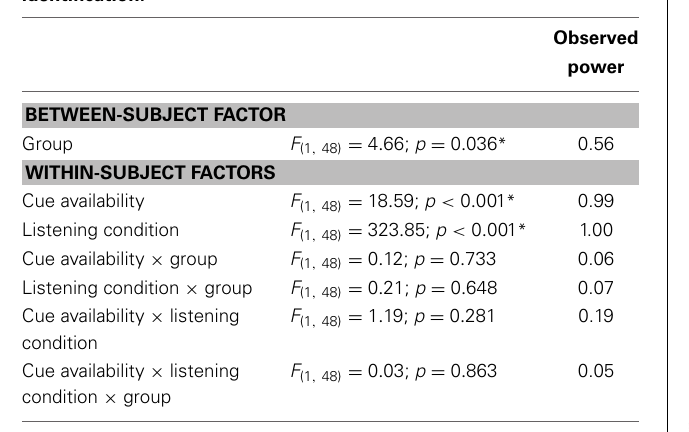
Table 4 | Experiment 2: Results of split-plot RM ANOVA for emotion identification.